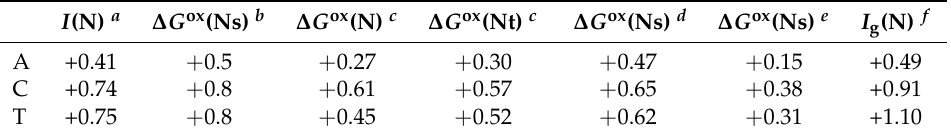
Table 1. Oxidation free energies ( ∆ G ox ) and adiabatic ionization energies ( I ) of DNA constituents relative to guanine or its derivatives. N, nucleobases; Ns, nucleosides; Nt, nucleotides. All data are expressed in eV. I (N) a ∆ G ox (Ns) b ∆ G ox (N) c ∆ G ox (Nt)